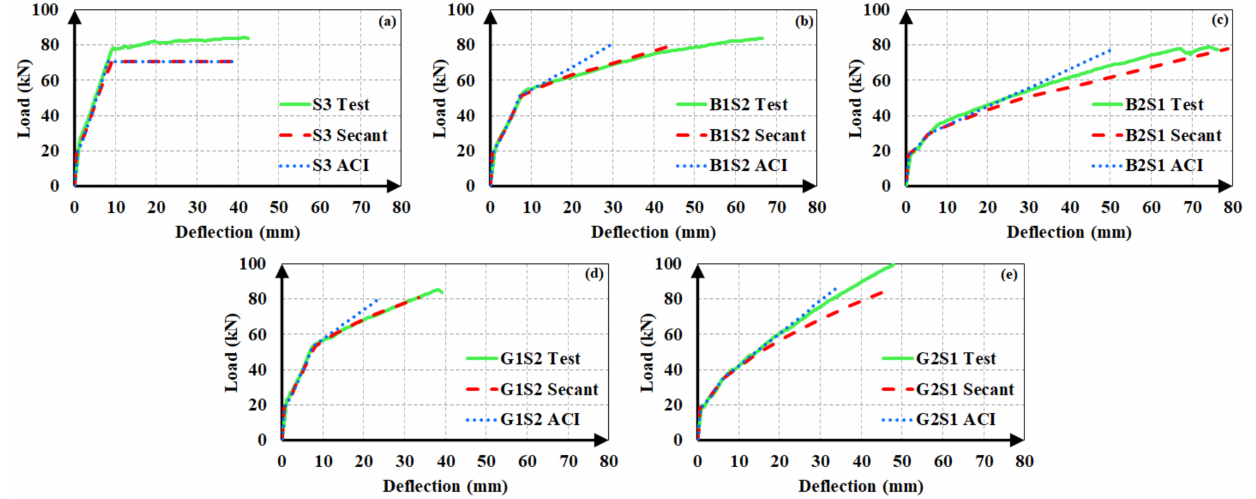
Figure 14. Experimental and analytical load-deflection curves of the third set of beams. ( a ) S3; ( b ) B1S2; ( c ) B2S1; ( d ) G1S2 and ( e )